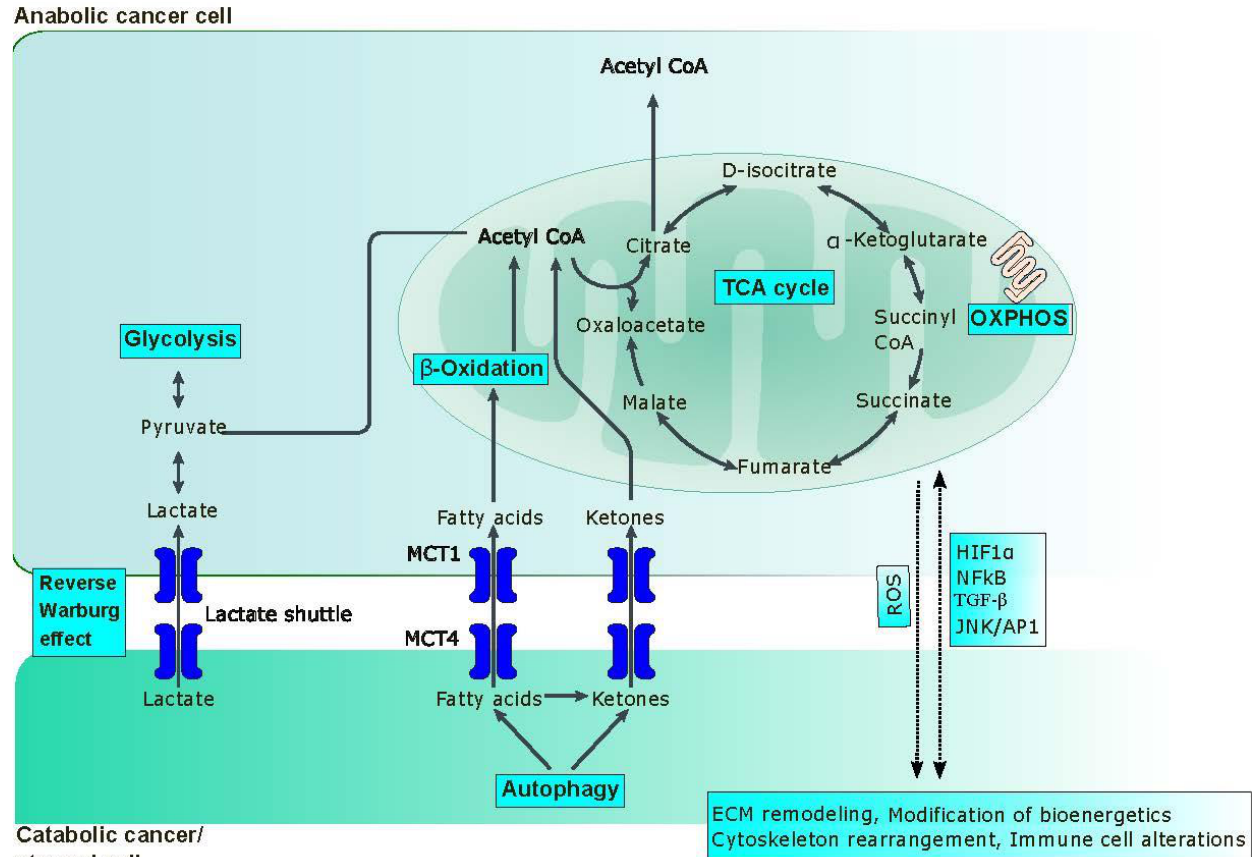
Figure 2. Metabolic adaptations and heterogeneity among cancer cells. Malignant cancer cells possess a high rate of metabolism similar to highly proliferative normal cells. Anabolic cancer cells intake high levels of ketones, fatty acids, and lactate from surrounding catabolic cells in order to replenish the TCA cycle and OXPHOS (reverse Warburg effect). ROS as a metabolic byproduct and HIF1α, NFkB, TGFβ, and JNK pathways , which are activated by the metabolic intermediates, contribute to tumorigenesis through ECM remodeling, altered bioenergetics, cytoskeleton alterations, and immune cell education. TCA, tricarboxylic acid cycle; OXPHOS, oxidative phosphorylation; ROS, reactive oxygen species.